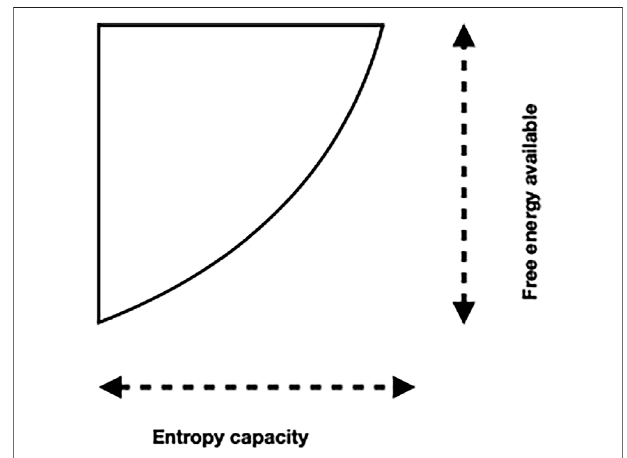
FIGURE 1 | An open systems ’ notional diagram of free energy abstracted from Gibbs. 11 From it, we see that an organization provides its team with suf fi cient Helmholtz free energy (the ordinate) “ from an external source ... (to maintain its) dissipative structure ” [85] by offsetting its waste and products produced (the abscissa). We illustrate with a notional diagram of free energy abstracted from Gibbs (closed